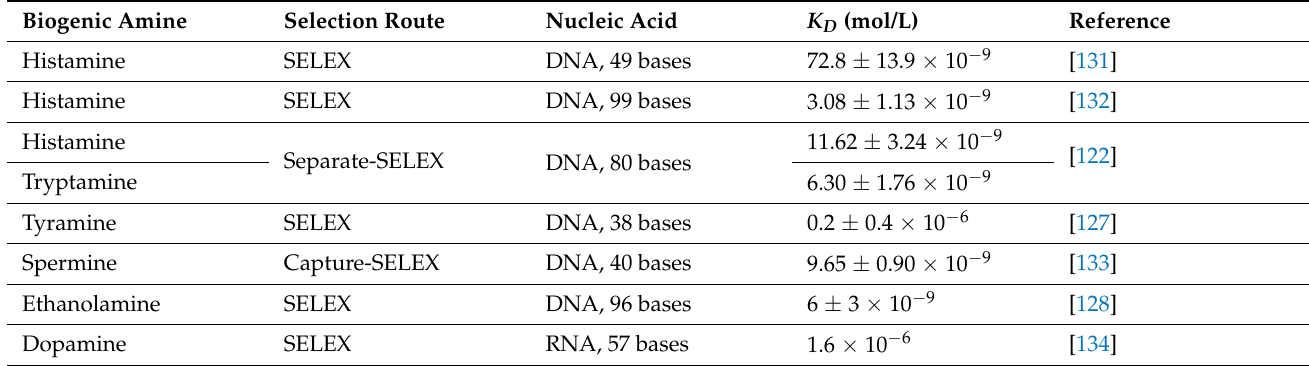
Table 1. Overview of aptamers developed for the recognition of a variety of biogenic amines together with their selection method, type and base number of the nucleic acid, and the dissociation constant K D . Low K D values correspond to a high level of selectivity. The references refer to the original work in which a given aptamer was reported for the first time, irrespective of follow-up work based on the earlier selected nucleotide